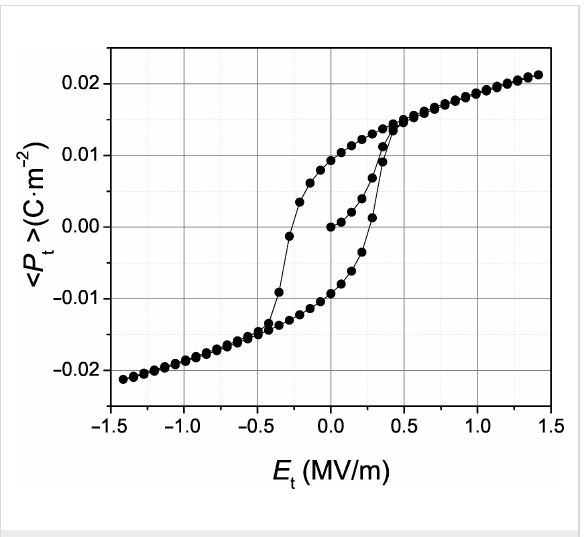
Figure 8: Calculated hysteresis loop demonstrating switching of the P t component of the Bloch wall located at a 1 nm thin SrTiO 3 layer. The indicated value of the polarization P t is averaged over the whole super- cell shown in Figure